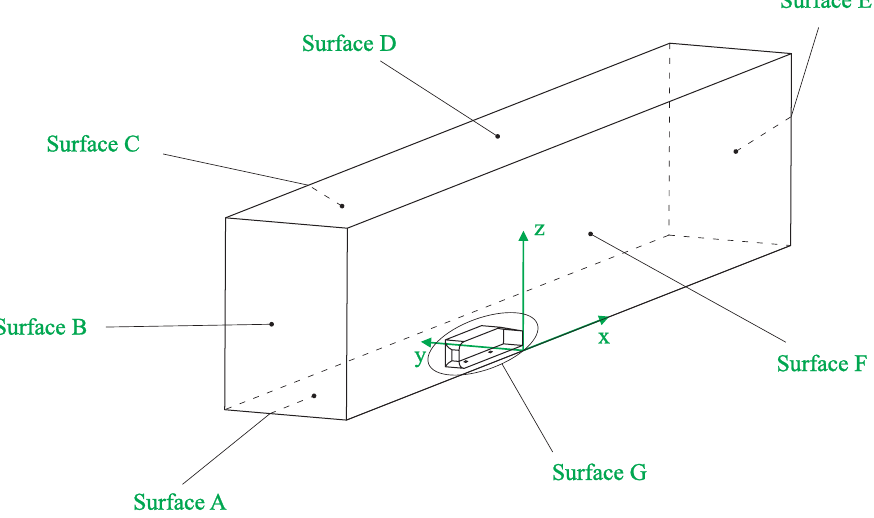
Figure 3. Surface description for boundary